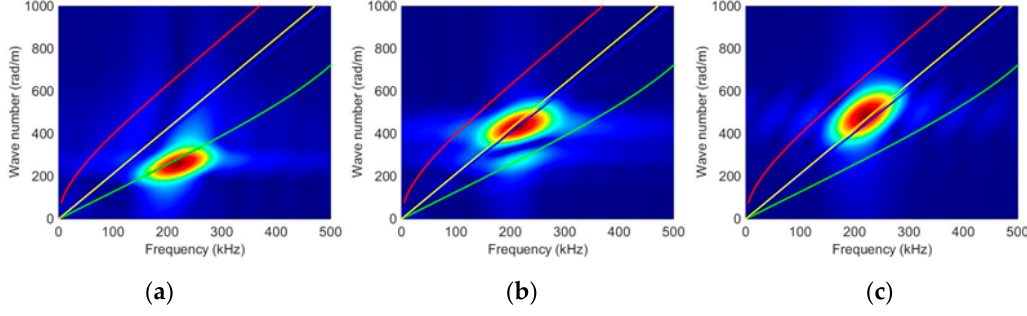
Figure 6. ( a ) Plots of the 2D FFT FE dispersion curve indicating ( a ) a dominant S0 wave in the r component; ( b ) a dominant SH0 wave in the θ component; ( c ) a symmetric edge-guided wave along the straight boundary.